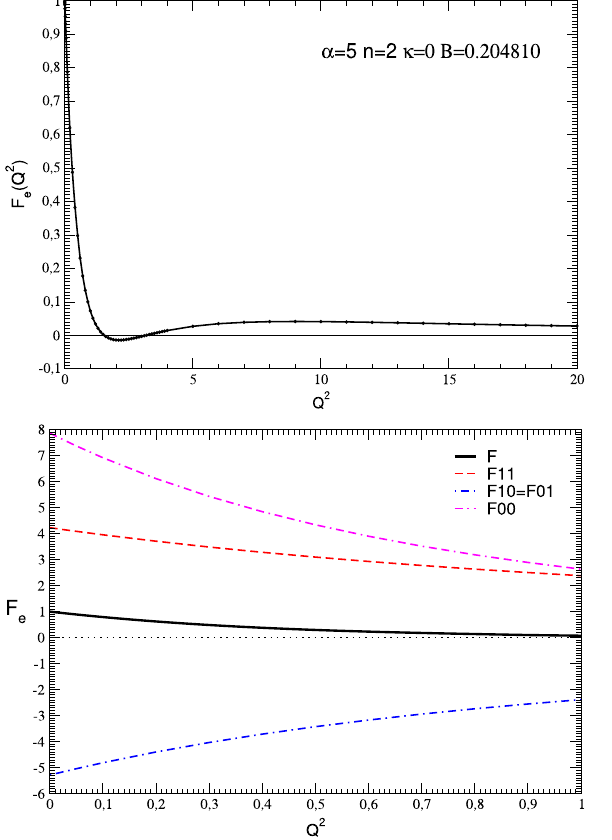
Fig. 14 Upper panel: elastic form factor of the normal state No. 2 of Table 1 ( n = 2, κ = 0). The different contributions F νν (cid:8) depending on g ν (cid:8) g ν are indicated in the lower panel 20 20